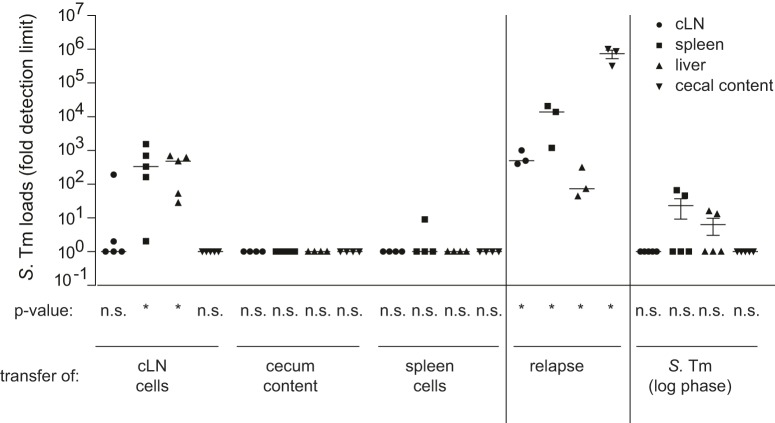

S. Tm in cLN from ciprofloxacin-treated mice are sufficient for initiating an infection.C57BL/6 mice were infected for 1 d with S. Tm before ciprofloxacin therapy was started (2×62 mg/kg/d by gavage). Recipient mice remained uninfected and were also treated with ciprofloxacin. (Left) 3 d p.i. mice were sacrificed and single-cell suspensions of the cLN or spleen or cecal content were transferred into antibiotic-treated naïve recipient mice. Four days later, recipient mice were sacrificed and pathogen loads in the respective organs were determined. Transfer of cLN cells leads to significantly higher infection rates compared to transferred spleen cells, cecum content, or S. Tm cultured in LB (right part; Fisher's exact test, p = 0.00482). (Middle) Relapse control. Mice were infected for 1 d with S. Tm, treated with ciprofloxacin for 2 d, and left untreated for 4 additional days. Then, we analyzed pathogen loads in the cecum content, cLN, spleen, and liver.